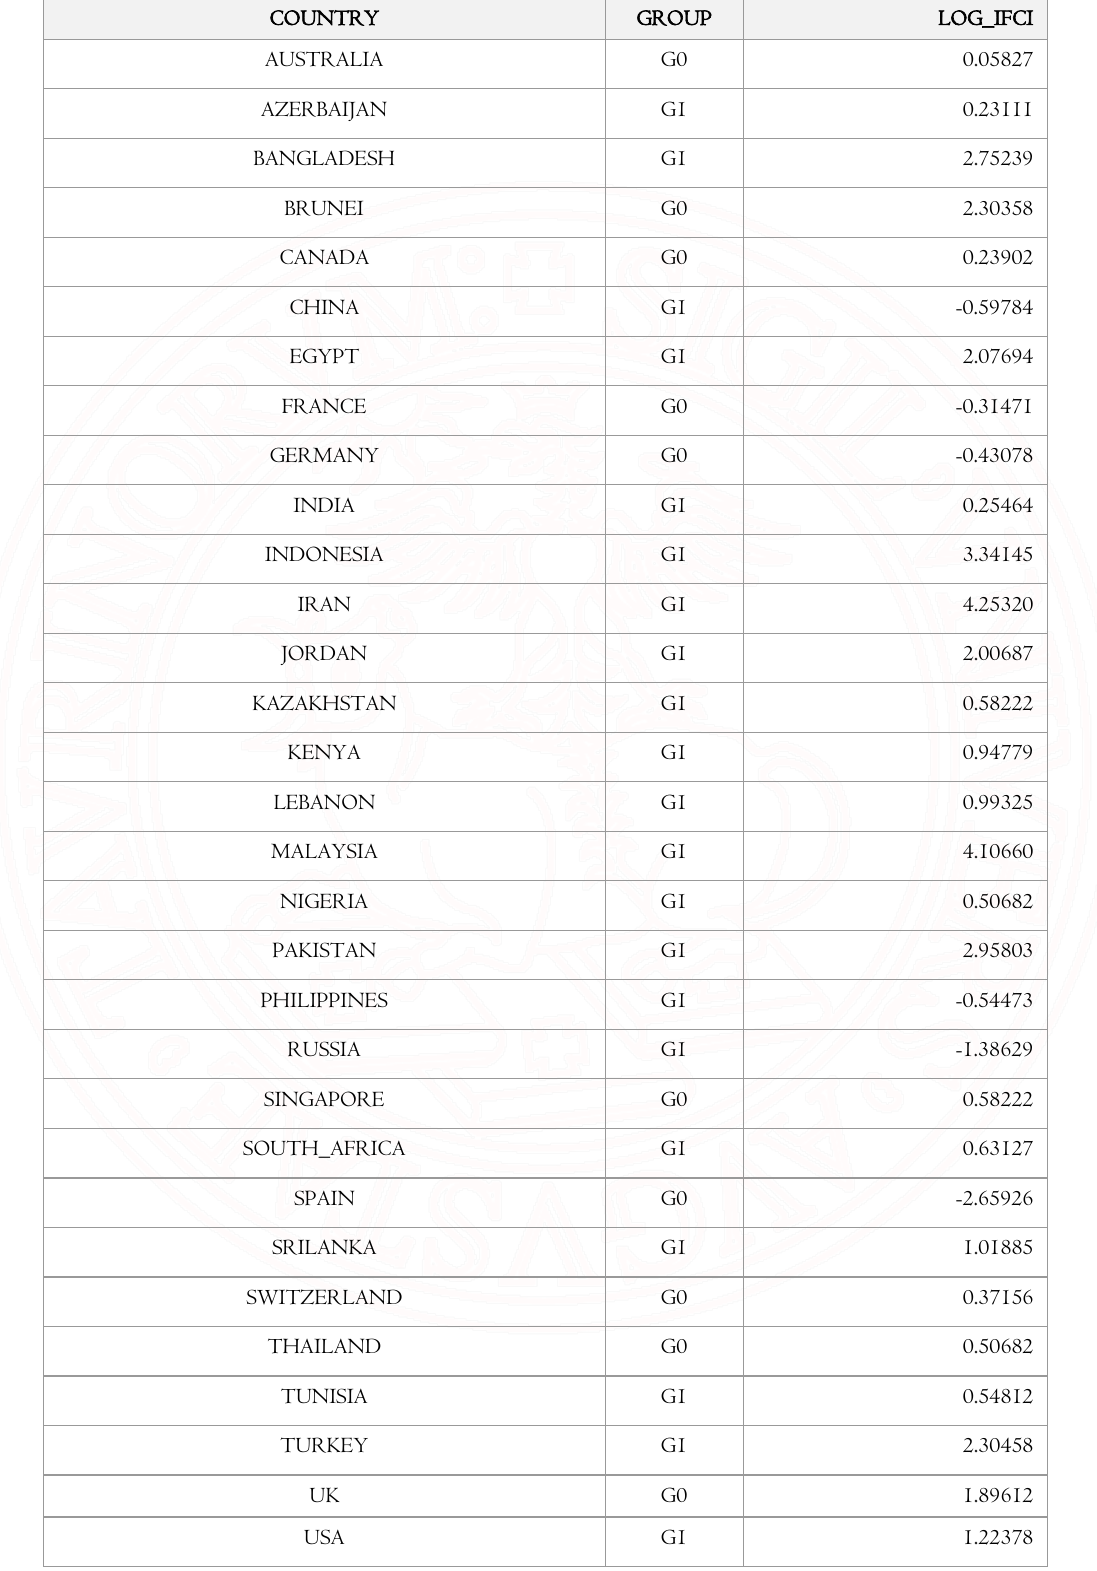
Table VII.LOG_IFCI and Yields Group (G0, G1, G2) by Country